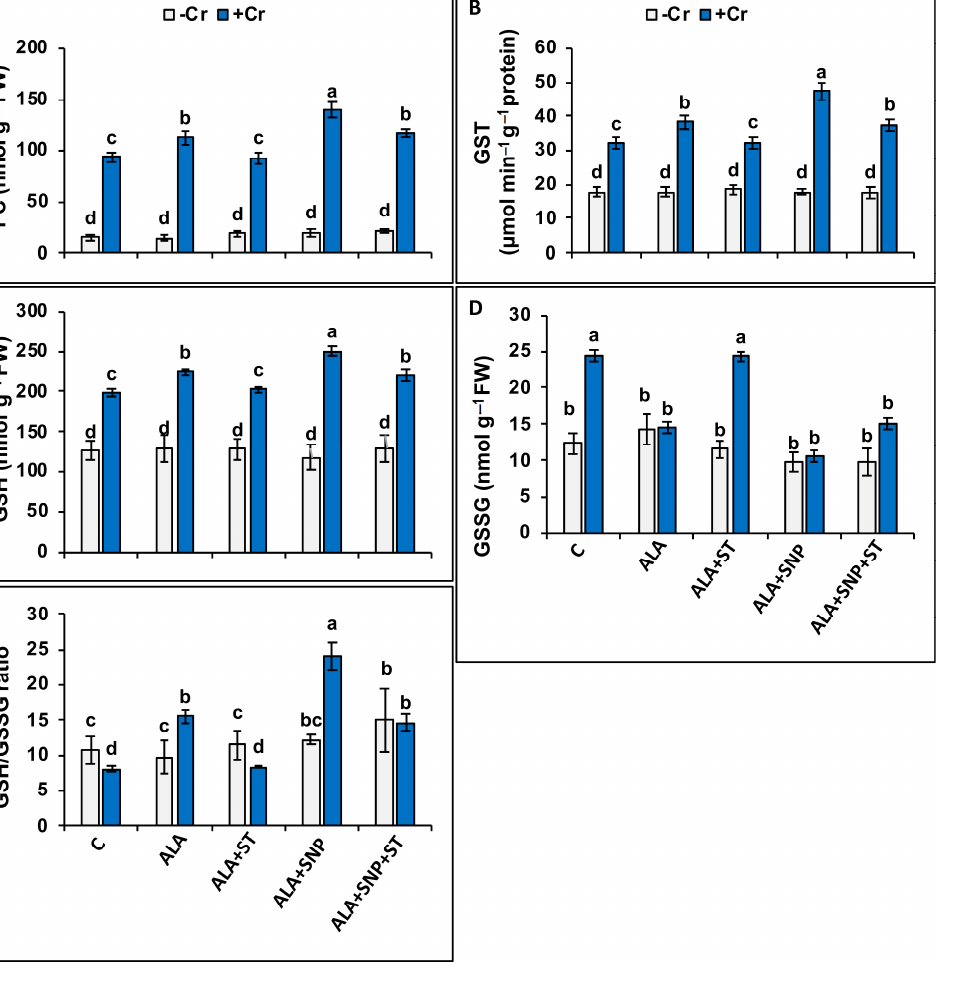
Figure 6. Phytochelatins (PC) ( A ), glutathione- S -transferase (GST) ( B ), reduced glutathione (GSH) ( C ), oxidized glutathione (GSSG) ( D ), and GSH/GSSG ( E ) in Cr-treated (+Cr) and non-treated ( − Cr) tomato seedlings sprayed with 20 mg L − 1 5-aminolevulinic acid (5-ALA), 0.1 mM sodium tungstate (ST) + 5-ALA, 5-ALA + 0.1 mM sodium nitroprusside (SNP), or 5-ALA + SNP + ST. Data are means ± S.E, different lower-case letters on bars reflect that mean values differ significantly at p ≤ 0.05.